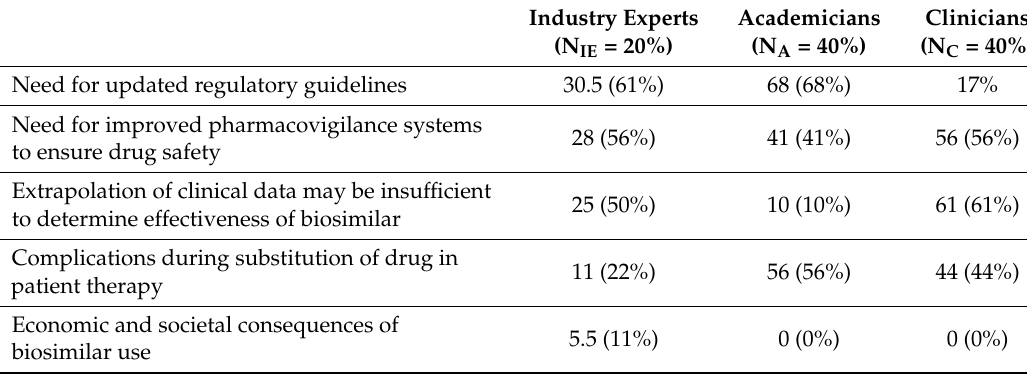
Table 3. Challenges of biosimilars according to Industry Experts, Academicians and Clinicians.